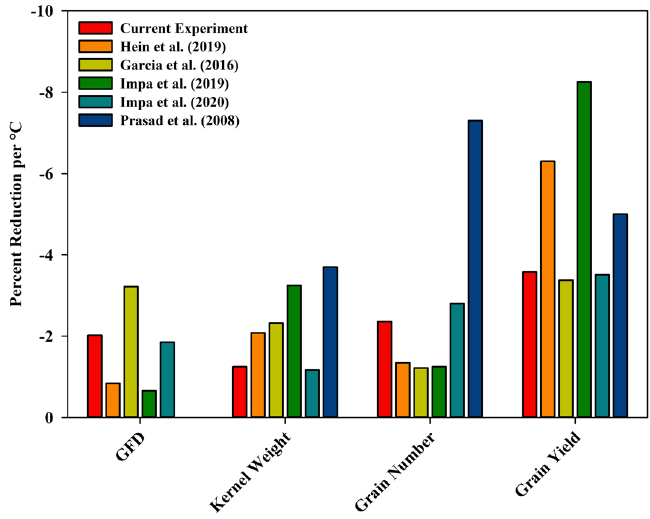
Figure 6. Graphical comparison of HNT stress impact on key agronomic parameters between six independent experiments in wheat. The results are presented as percent reduction per °C of heat stress and represents the average of all genotypes within the experiment. If multiple HNT stress levels were tested in a single experiment, the average reduction was calculated for each treatment level and then the results of each treatment were averaged to gain an overall experimental percent reduction. In the current experiment HNT stress was imposed post-anthesis through maturity with an average stress level of + 3.8 °C and control of 18 °C. In Hein et al. 30 (field- based) HNT stress was imposed post-anthesis through maturity with an average stress level of + 3.2 °C with a 22 °C control. Both Hein et al. 30 and the current study had 12 winter wheat genotypes. In Garcia et al. 28 (field- based) HNT stress was imposed post-anthesis through maturity with an average stress level of + 4.15 °C during two different years (+ 4.9 °C with a 17 °C control and + 3.4 °C with a 14.3 °C control) with a single genotype